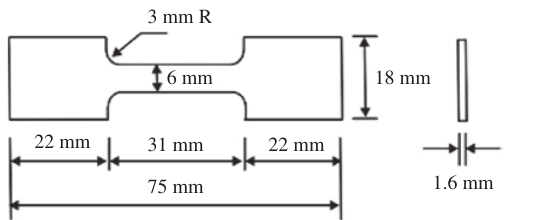
Transformer oil